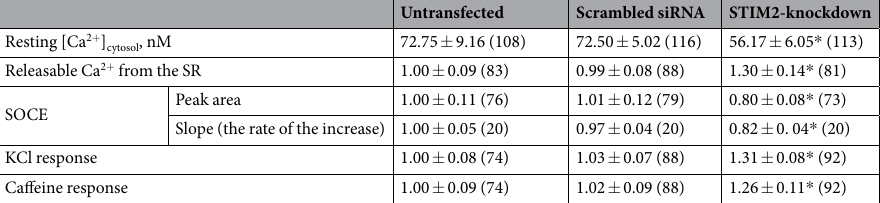
in skeletal muscle. STIM2 binds to SERCA1a via its C-terminal region of amino acids from 453 to 729, and atten- uates SERCA1a activity during skeletal muscle contraction. It seems that STIM2 could be involved in a moderate level of Ca 2 + -uptake to the SR through SERCA1a by attenuating SERCA1a activity in order to maintain skeletal muscle contraction for longer periods. During SOCE, three dimers of STIM1 (i.e., six STIM1s) are required to activate ‘a’ functional hexameric